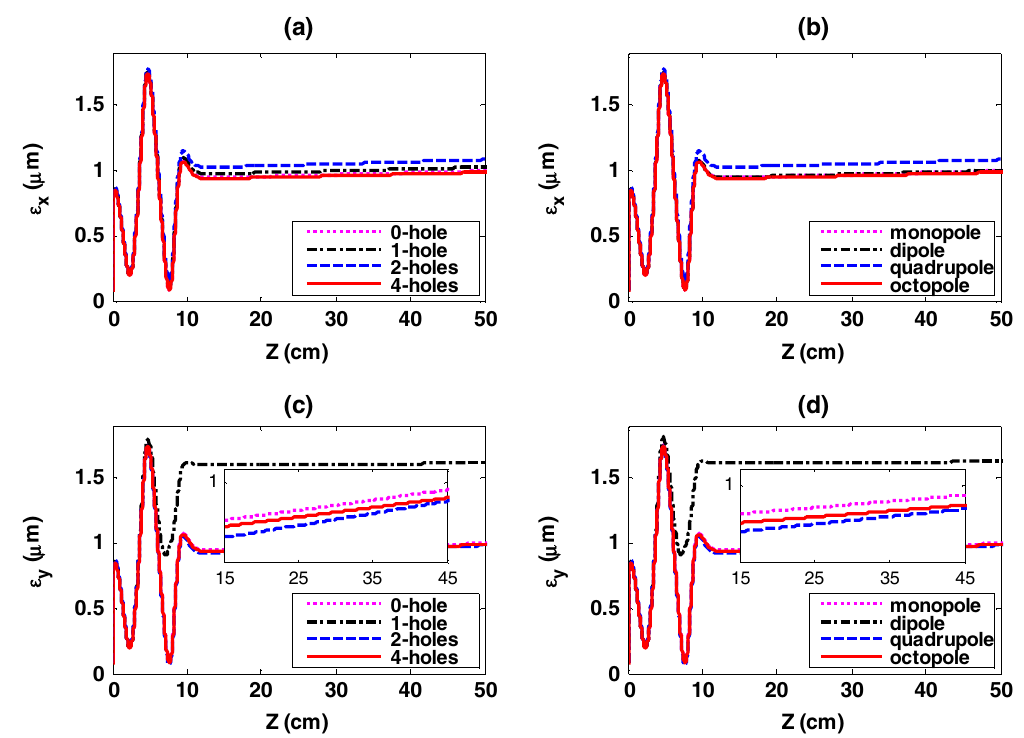
FIG. 7. Simulation results of rms emittance in both directions without solenoid field for the beam charge of 0 nC. (a) Emittance evolutions in the horizontal ( x ) direction for each model. (b) Emittance evolutions from the dominant multipole field from each model in the horizontal ( x ) direction. (c) Emittance evolutions in the vertical ( y ) direction for each model. (d) Emittance evolutions from the dominant multipole field from each model in the vertical ( y )